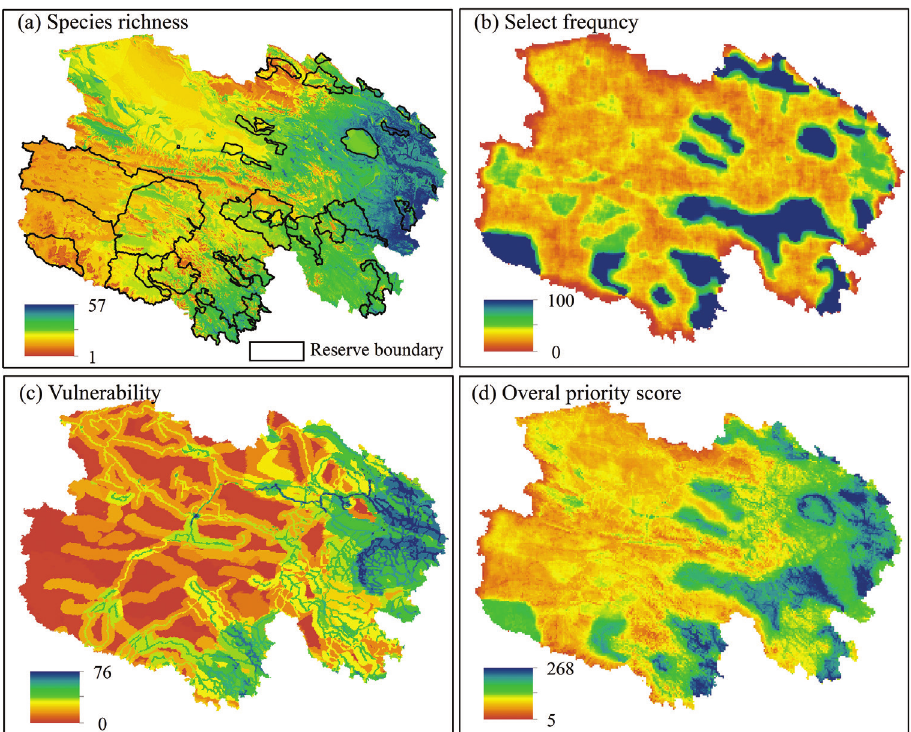
Figure 4. Spatial distribution maps for the three criteria used to evaluate the conservation priority of the proposed conservation areas in this study: a species richness and current nature reserves across Qinghai Province b vulnerability, derived from the Human Footprint index c selection frequency of the planning units, including additional solutions with varying conservation goals; and d overall priority